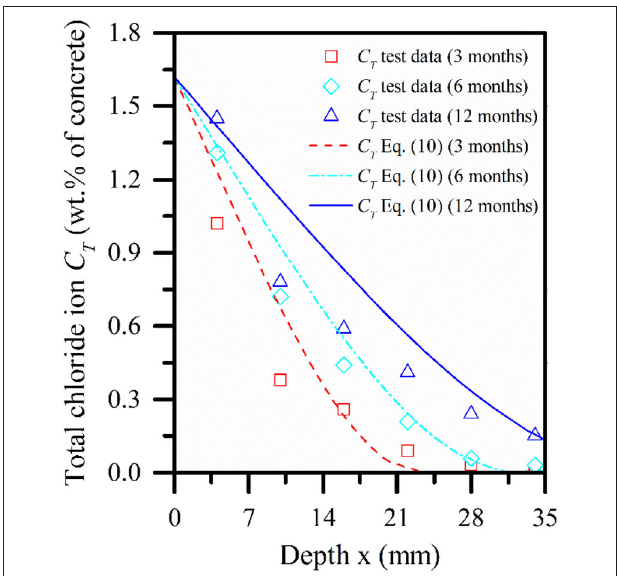
FIGURE 5 | Simulation and test comparison of total chloride ions in concrete beams exposed for 3, 6, and 12 months.